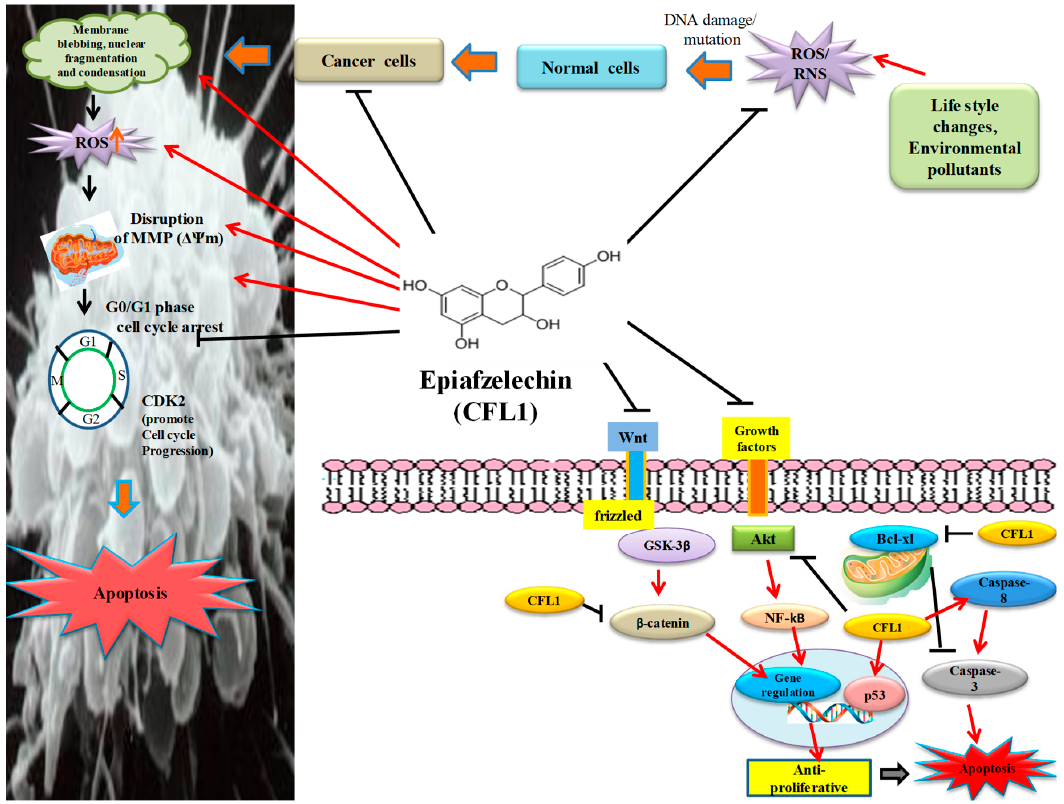
Figure 18. Proposed mechanism of action of the chemopreventive potential of Epiafzelechin (CFL1) isolated from Cassia fistula L.